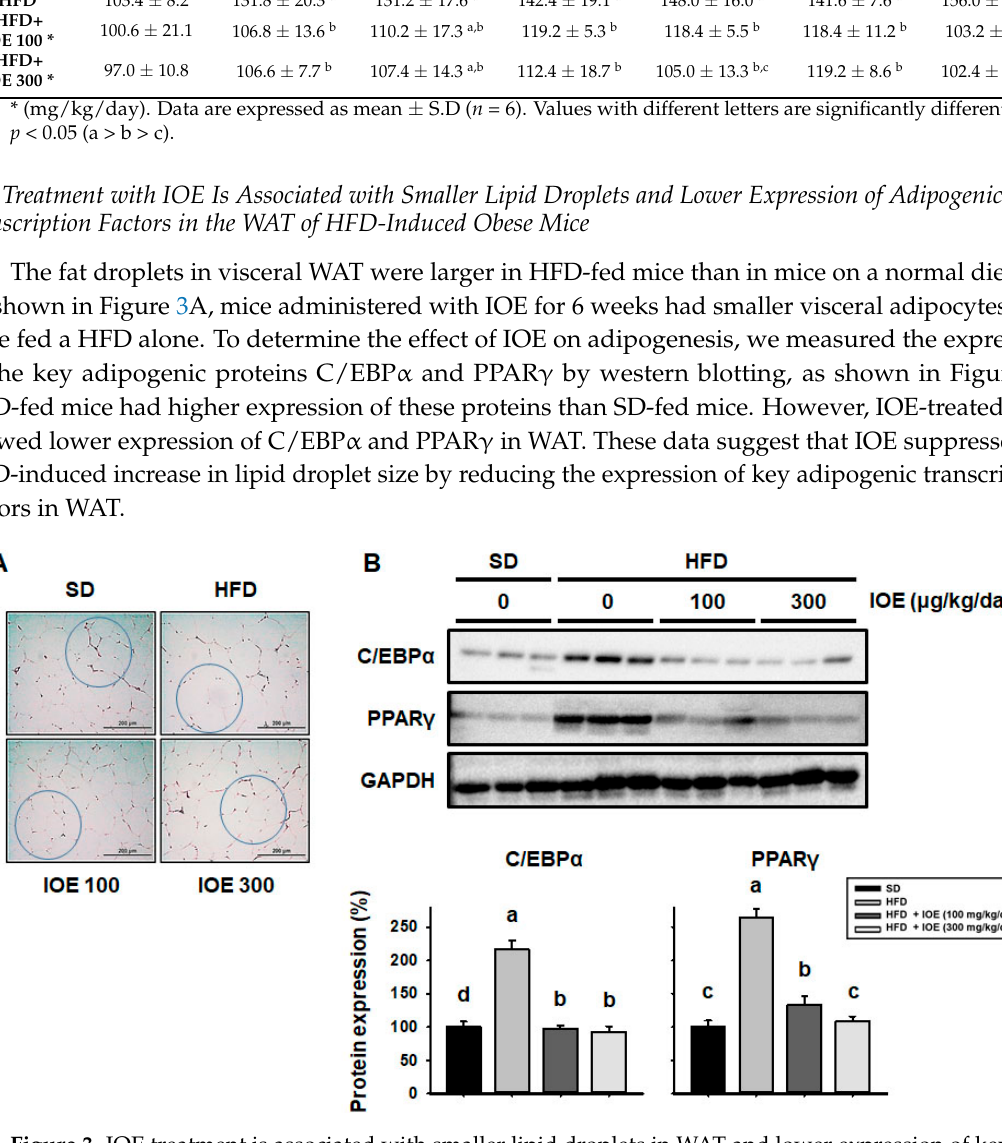
Table 3. Effect of treatment with IOE on fasting blood glucose in mice that were HFD-fed for 6 weeks. Group Fasting Blood Glucose (mg/dL) Group 0 Week